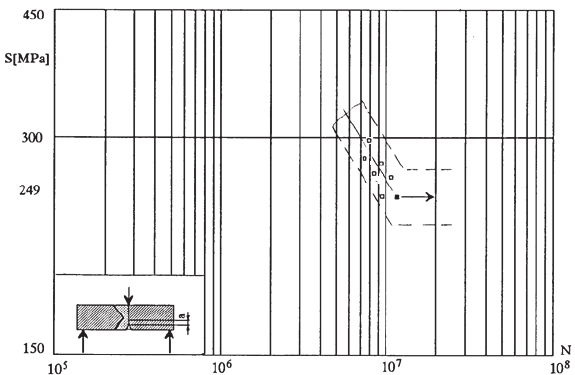
Figure 6: S-N Relationship for specimens with initial crack a=0.591 mm.